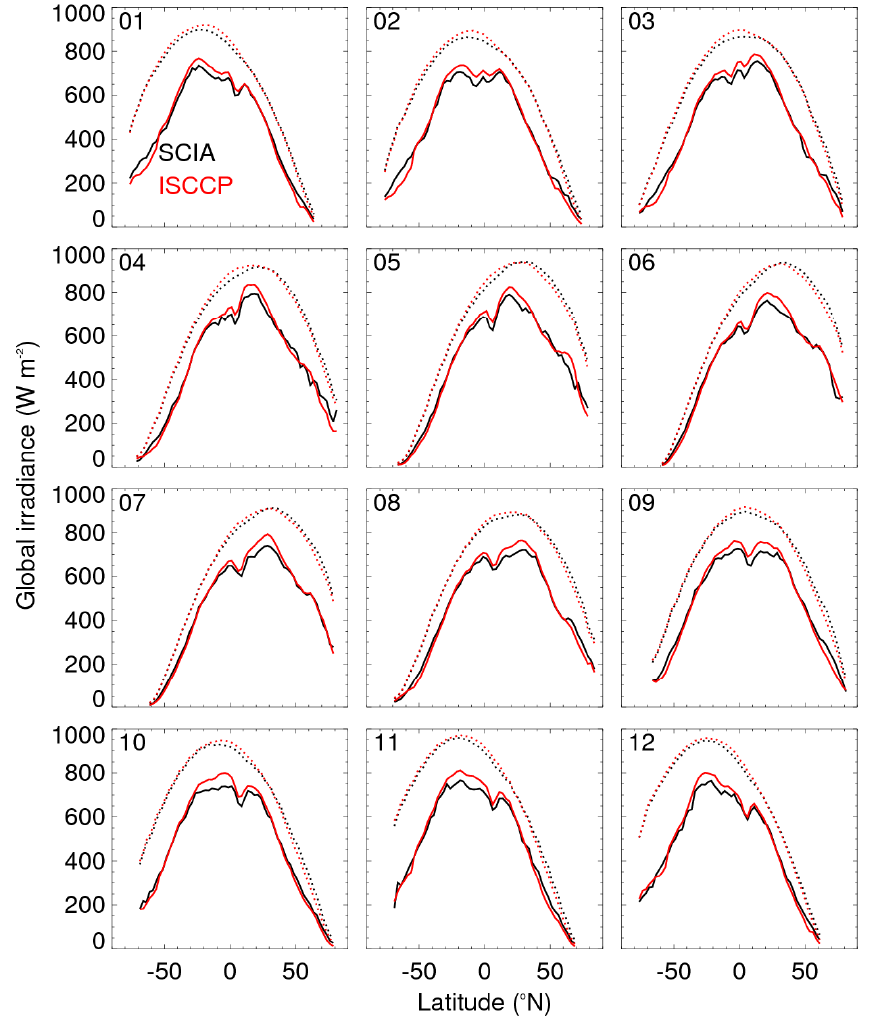
Fig. 8. Zonal means of the SCIAMACHY surface solar irradiances (black) and the ISCCP-FD surface shortwave downwelling fluxes (red) in January–December 2006. The solid lines show the full-sky global irradiances ( G ) and the dotted lines illustrate the clear-sky global irradiances ( G clr